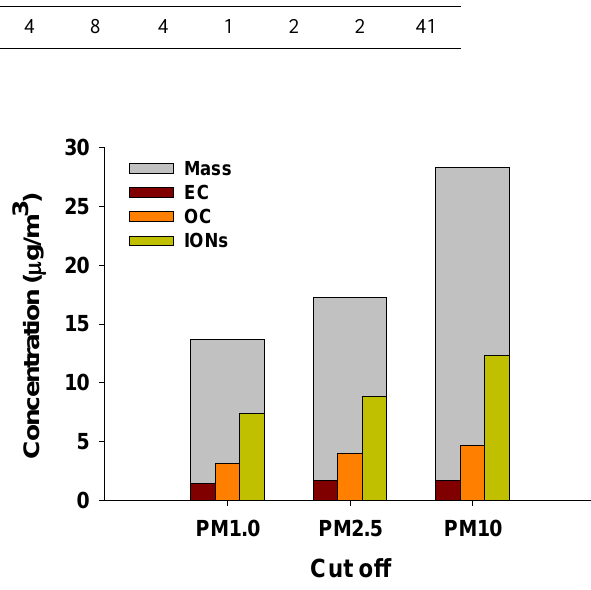
Fig. 2. Mean concentrations of mass, water-soluble ions, EC, and OC in PM 1 . 0 , PM 2 . 5 , and PM 10 . Ions include SO 2 − Cl − for anions and NH +